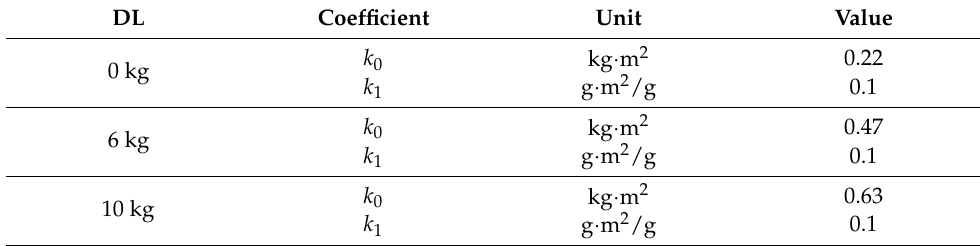
Figure 21. Estimation of the overall inertia; experimental results obtained with the proposed method. Table 2. Linear regression results.